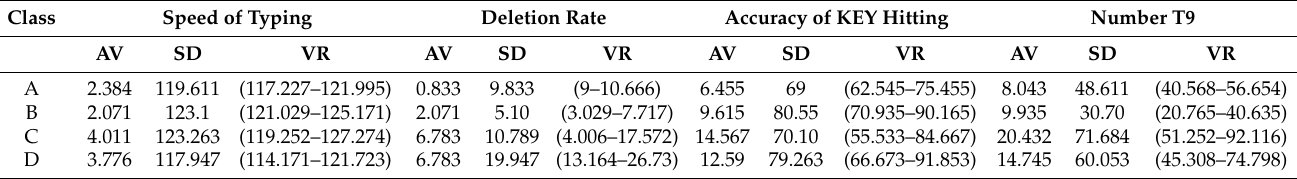
Table 4. Average values (AV), standard deviations (SD), and values ranges (VR).